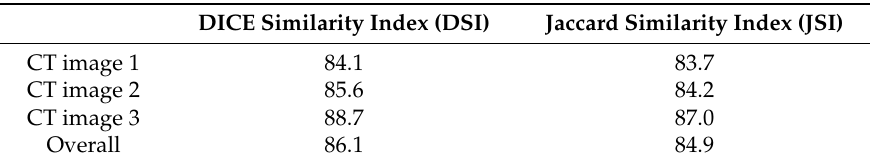
Table 3. Segmentation results.